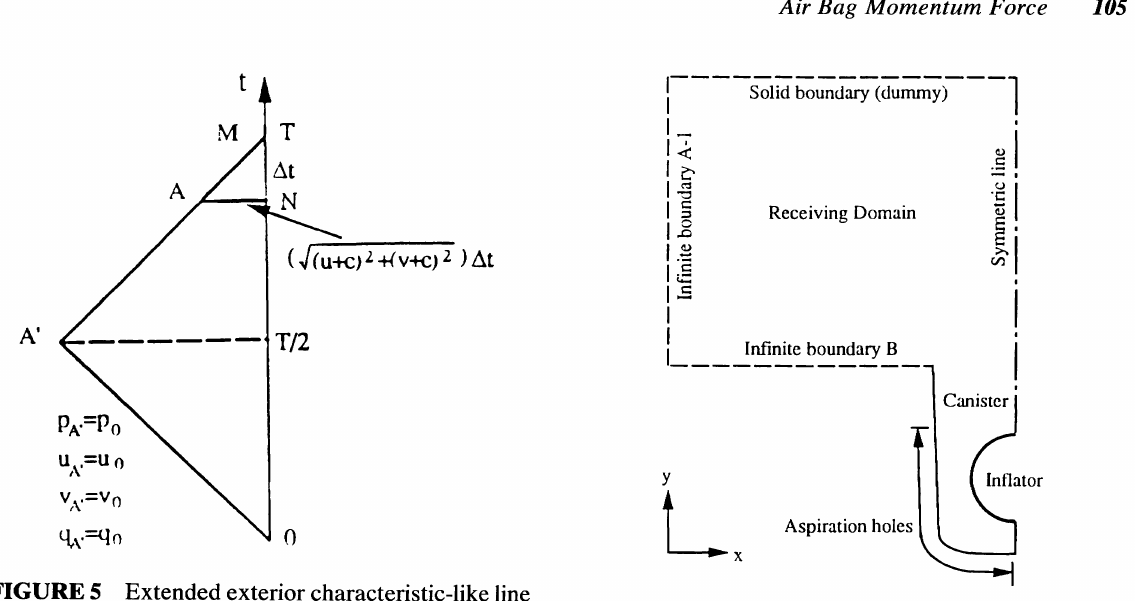
FIGURE 5 Extended exterior characteristic-like line (B) at infinite left boundary. FIGURE 6 The schematized computational